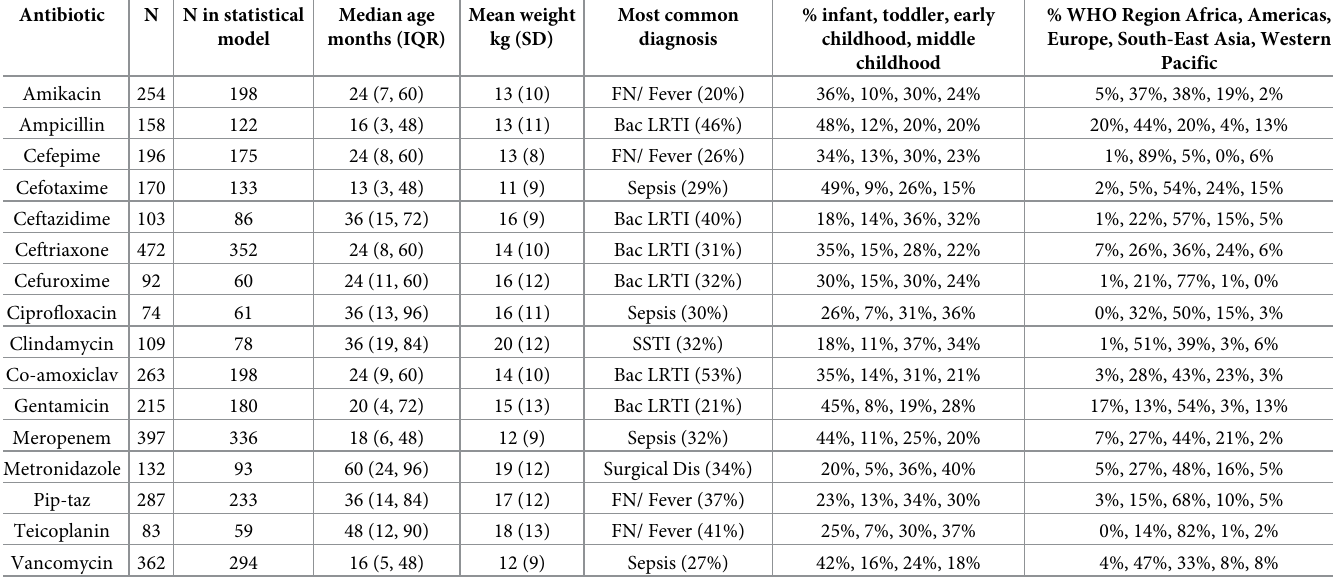
Table 1. Patient characteristics split by antibiotic.